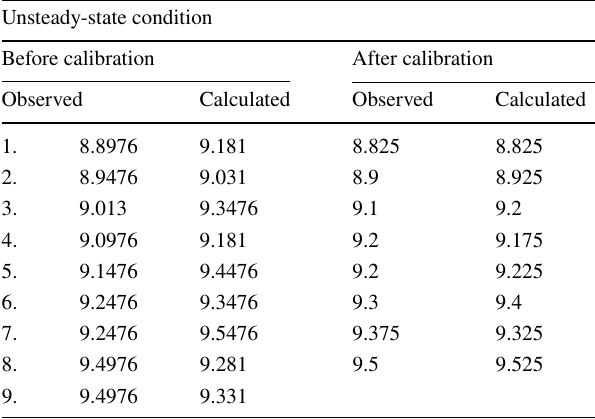
Table 11 Measured and simulated head in 9 observation wells of Quaternary aquifer (unsteady state) Unsteady-state condition Before calibration After calibration Observed